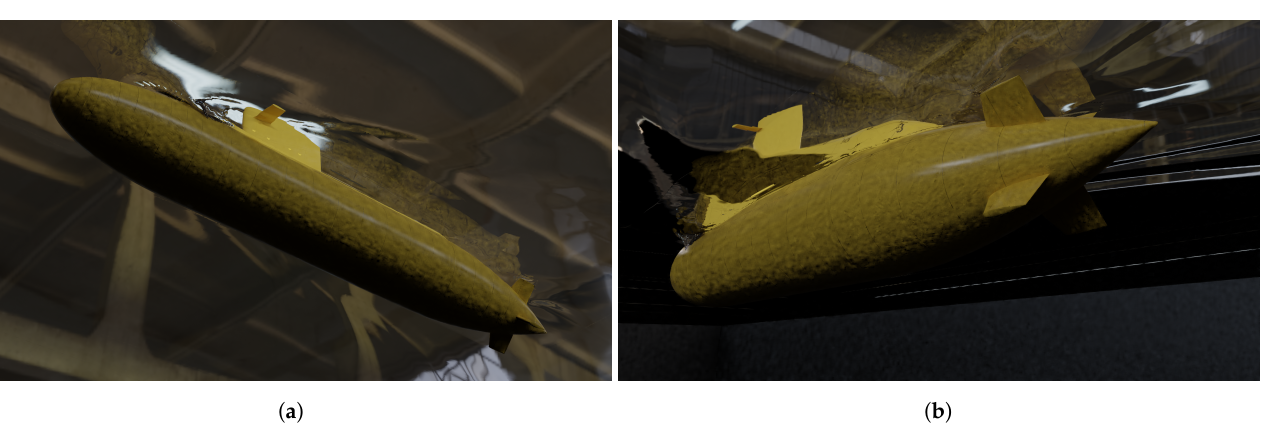
Figure 9. BB1 submarine Blender visualisation below the water surface, focused on ( a ) the bow and ( b ) the stern. Free-surface extracted using an air volume fraction iso-contour of